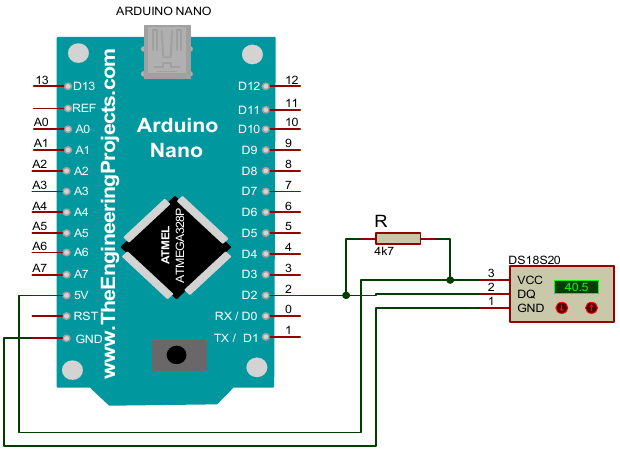
Figure 4. Temperature sensor circuit.